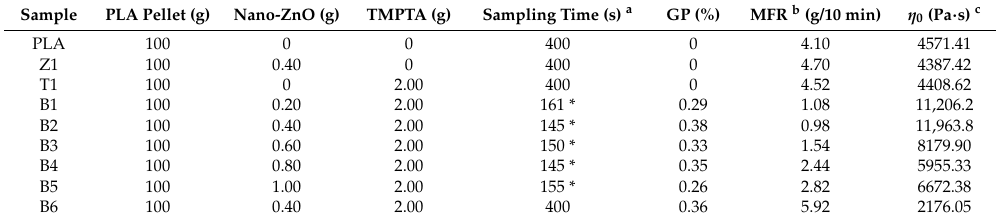
Table 1. Formulation of the experiment and the corresponding measurement